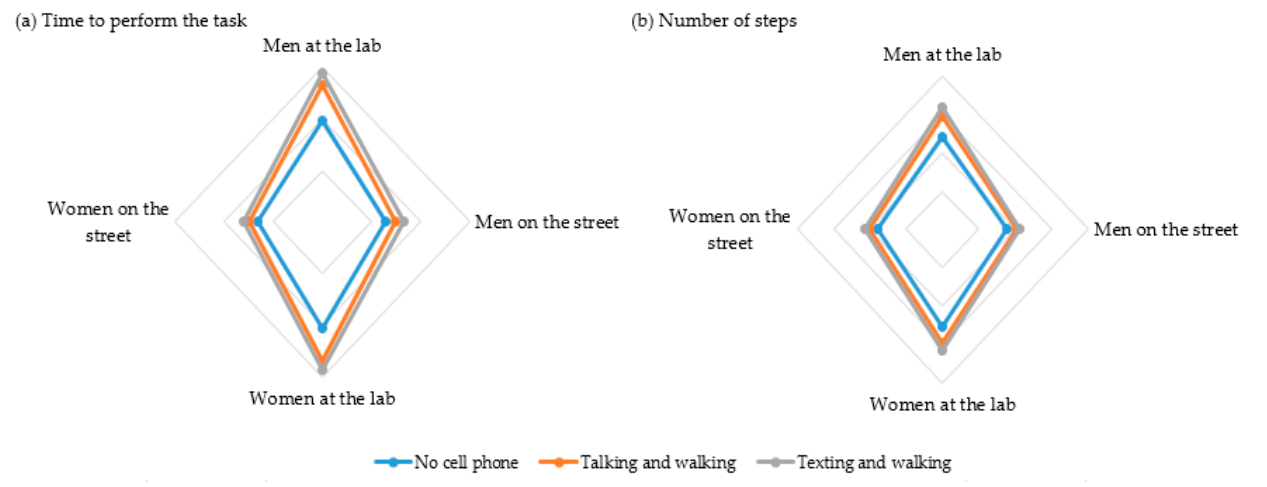
Figure 1. Performance of the participants according to time ( a ), number of steps ( b ), sex, task, and environment. Table 3. Effect sizes, power, and significance of the multiple analyses of variance